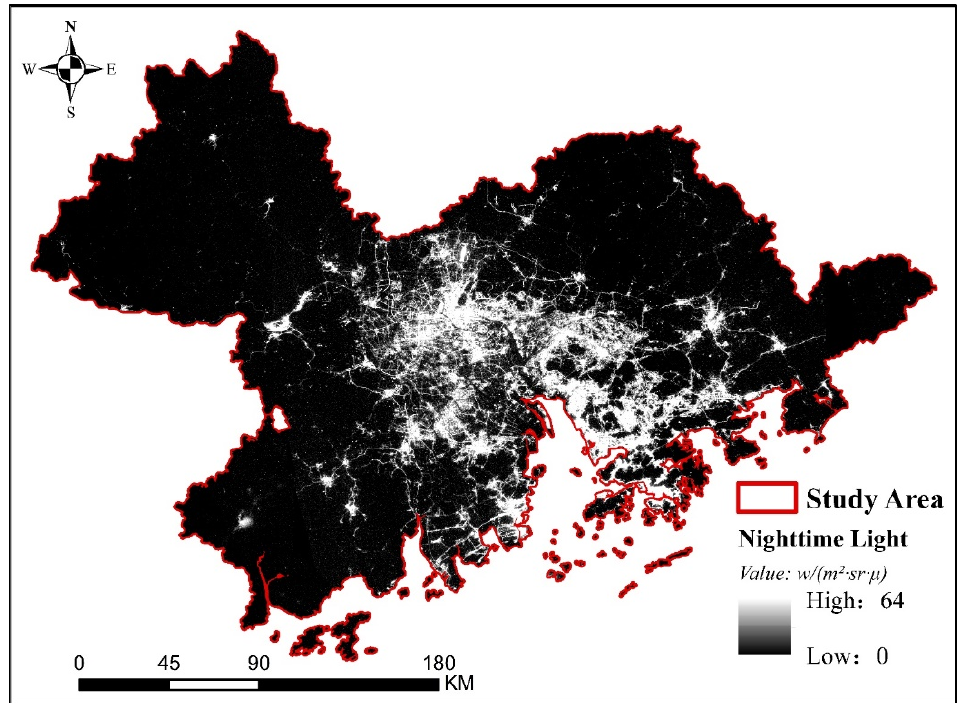
Figure 2. Preprocessing result of nighttime light data in the GBA.